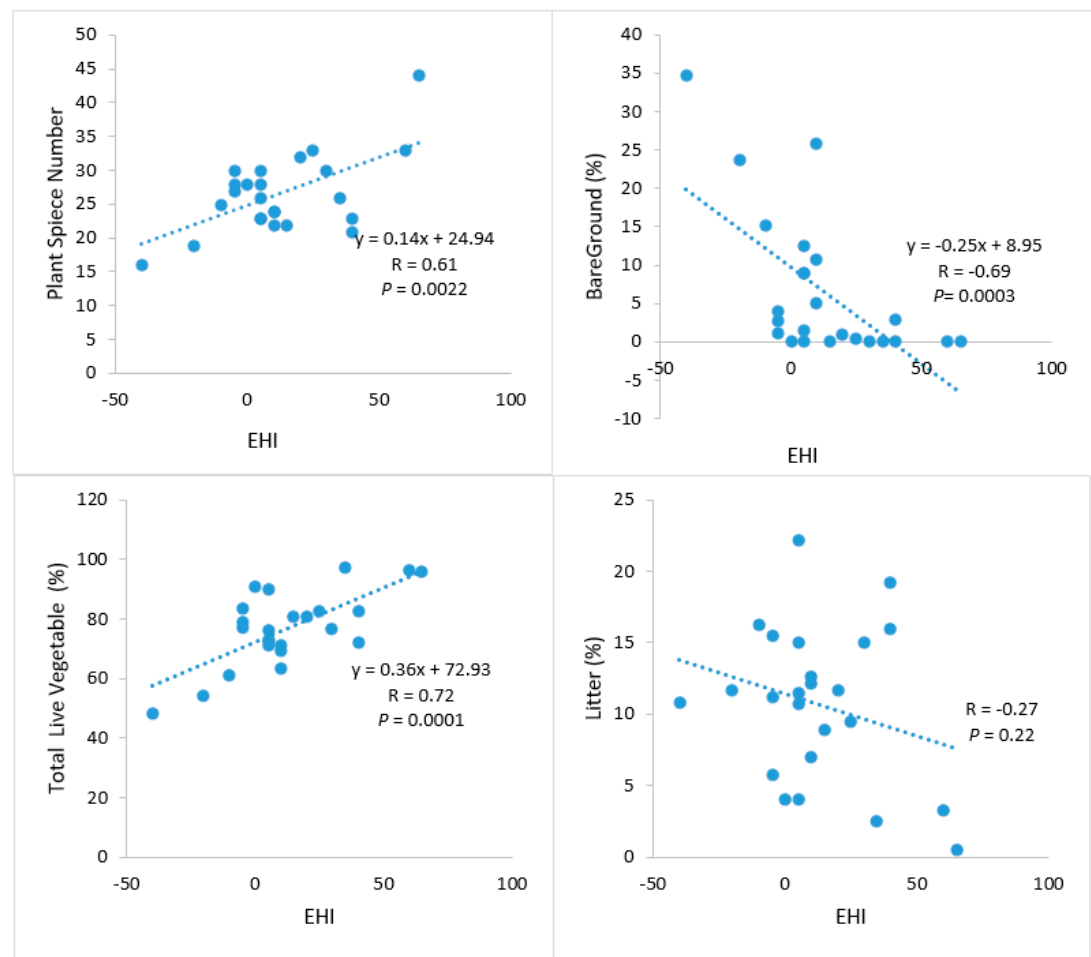
Figure 2. Linear regression for HMS between EHI and QMs species richness (R = 0.61), cover percentage of total live vegetation percentage (R = − 0.69), bare ground (R = 0.72) and litter (R = − 0.27).